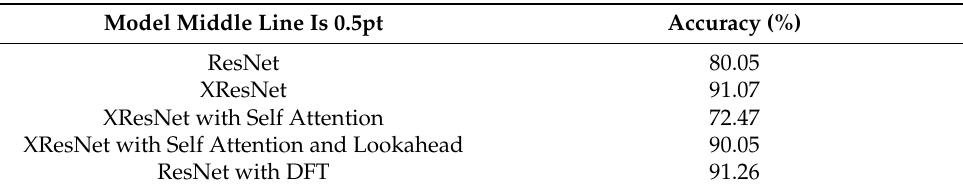
Table 4. Training Accuracy for each